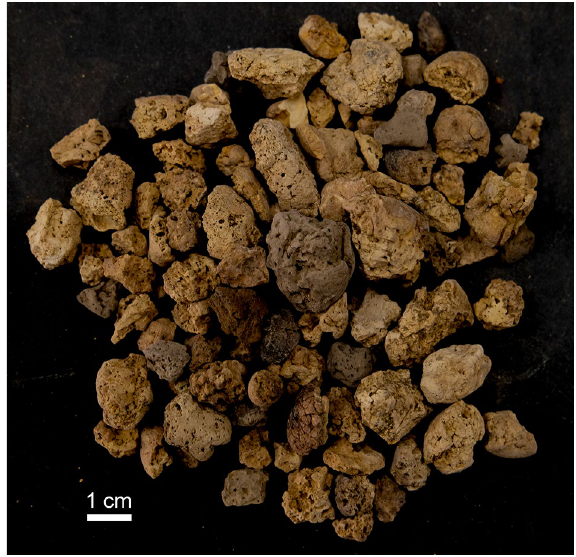
Figure 3. Shapeless coprolites recovered after sieving layer 143 sediments (square G6). Some specimens are burned due to human activity at the